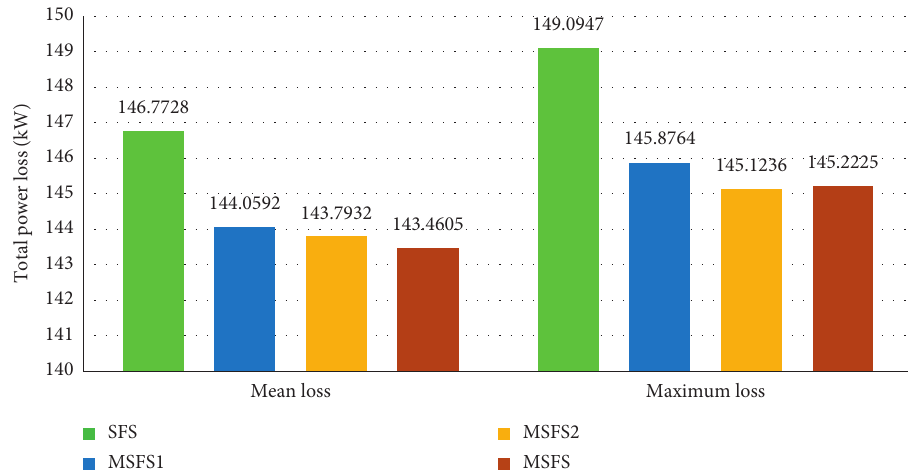
Figure 29: Mean and maximum power loss of 50 trial runs obtained by SFS methods for case 4 of the 85-bus system.